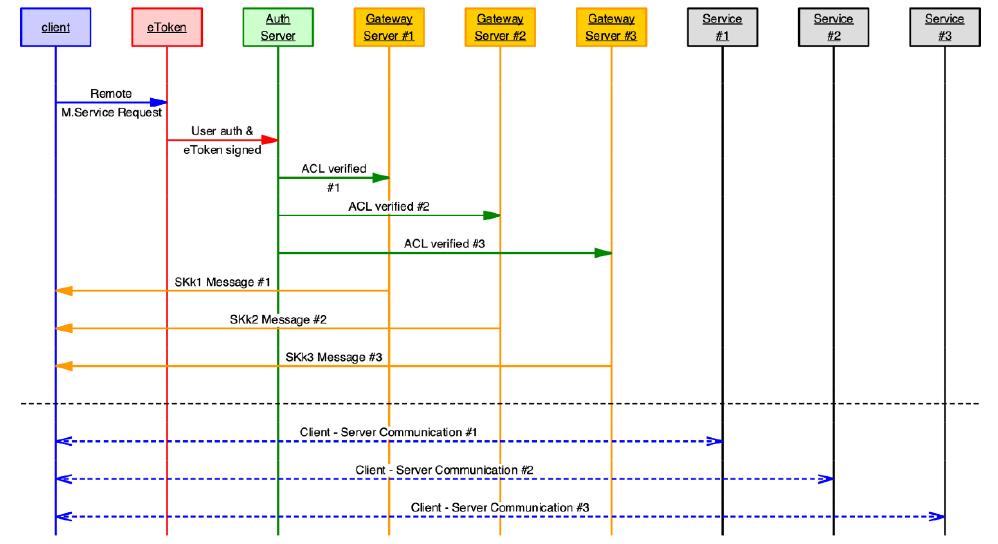
Figure 5. Message sequence chart between the elements of the system in a multiservice request.